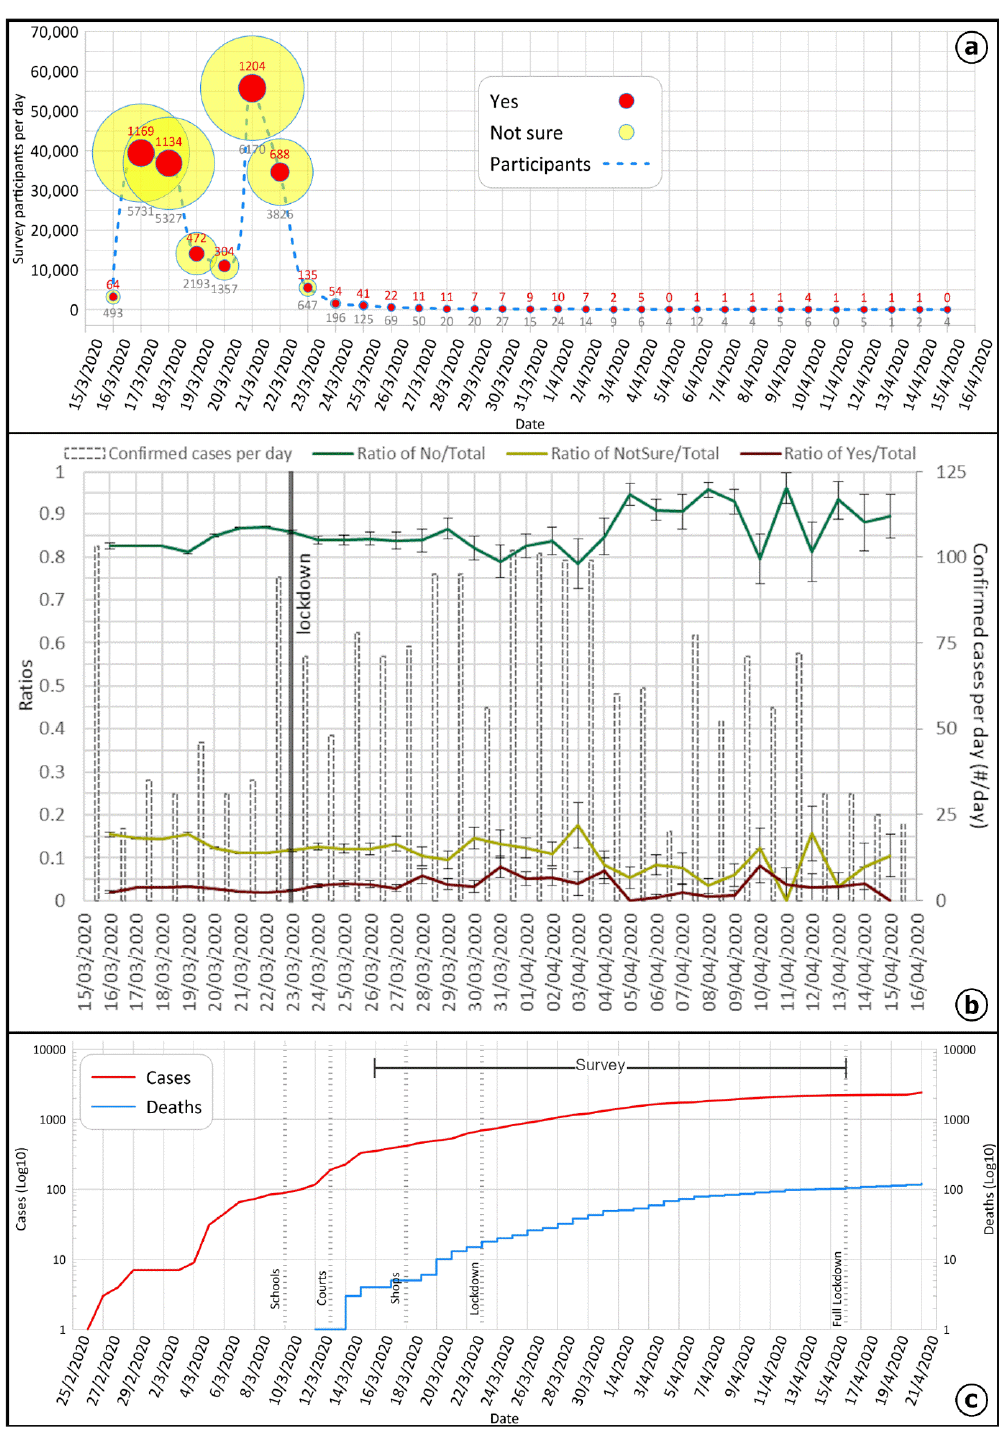
Figure 4. Temporal evolution for the Greek territory of ( a ) the number of participants per day with the number of Yes and Not Sure annotated; ( b ) ratios of the three different answers per day (left axis), compared to the confirmed cases (number/day; right axis); ( c ) the confirmed cases and deaths per day since the recording of the first confirmed case in Greece. Critical restriction of activities is also indicated with vertical solid or dashed lines.